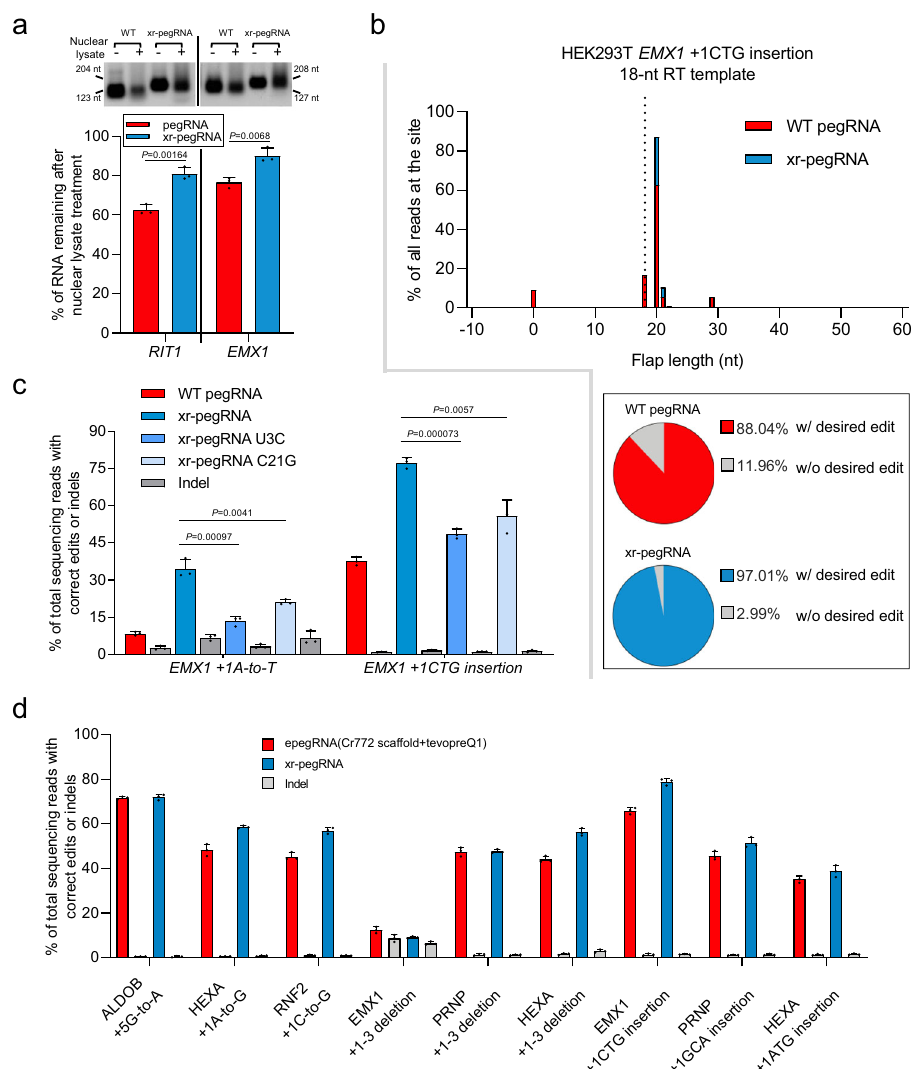
Fig. 5 The 3 ′ xrRNA stabilizes xr-pegRNA to enhance prime editing, resulting in comparable performance as the latest epegRNA-based strategy. a The stability of in vitro-transcribed WT pegRNAs or the corresponding xr-pegRNAs upon exposure to HEK293T nuclear lysates. A representative agarose gel with samples from biological triplicates is shown. The sizes of the products (nt) are marked on the side. The levels for untreated WT pegRNAs or xr- pegRNAs were considered as 100%. Data presented are from quantitation of band intensity from 3 biological replicates (mean ± SD). The amounts of remaining pegRNAs or xr-pegRNAs were compared (two-tailed Student ’ s t tests, with P values marked). b Comparison of PE intermediates generated by PE2 with either WT pegRNAs or xr-pegRNAs at EMX1 site in HEK293T cells. The black dotted line represents the end of the full-length RT template (18 nt). In the histogram, the x axis corresponds to the sizes of the 3 ′ fl aps, with the fi rst base downstream of the PE2-induced nick denoted as position + 1, while the y axis represents the relative abundance of the reads (percentage of all reads). The bottom box contains pie charts showing percentages of reads with (red/blue) or without (gray) intended edits. The data presented are calculated from an average of three independent biological replicates. c The WT pegRNA, xr-pegRNA, and two mutant xr-pegRNAs bearing either U3C or C21G mutations at the xrRNA domain were used in a PE3 context for base conversion or insertion at the EMX1 sites in HEK293T cells. The editing ef fi ciencies were determined (mean ± SD, n = 3 biological replicates) and compared (two-tailed Student ’ s t tests, with P values marked). d The ef fi ciencies by PE with xr-pegRNA (xrPE), or epegRNA (containing tevopreQ1 motif and Cr772 scaffold) for nine different genetic modi fi cations attempted in our earlier experiments. Gray bars next to the red/blue-colored bars indicates the indel frequencies in association with a particular experiment group, where the editing ef fi ciency is shown in red or blue (mean ± SD, n = 3 biological replicates). Source data are provided as a Source Data fi